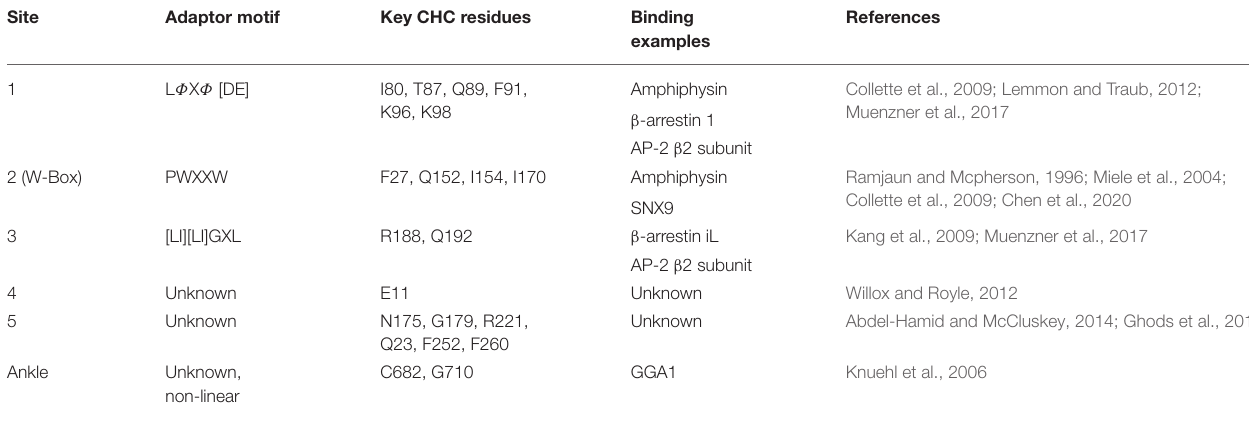
TABLE 1 | Summary of the currently known and proposed binding sites of the clathrin terminal domain, detailing key residues, and binding